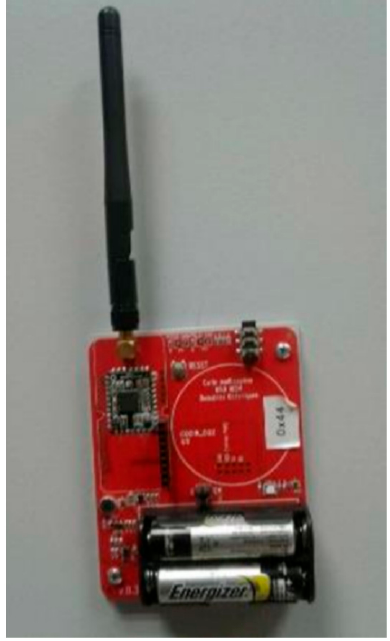
Figure 4. THLN sensor.